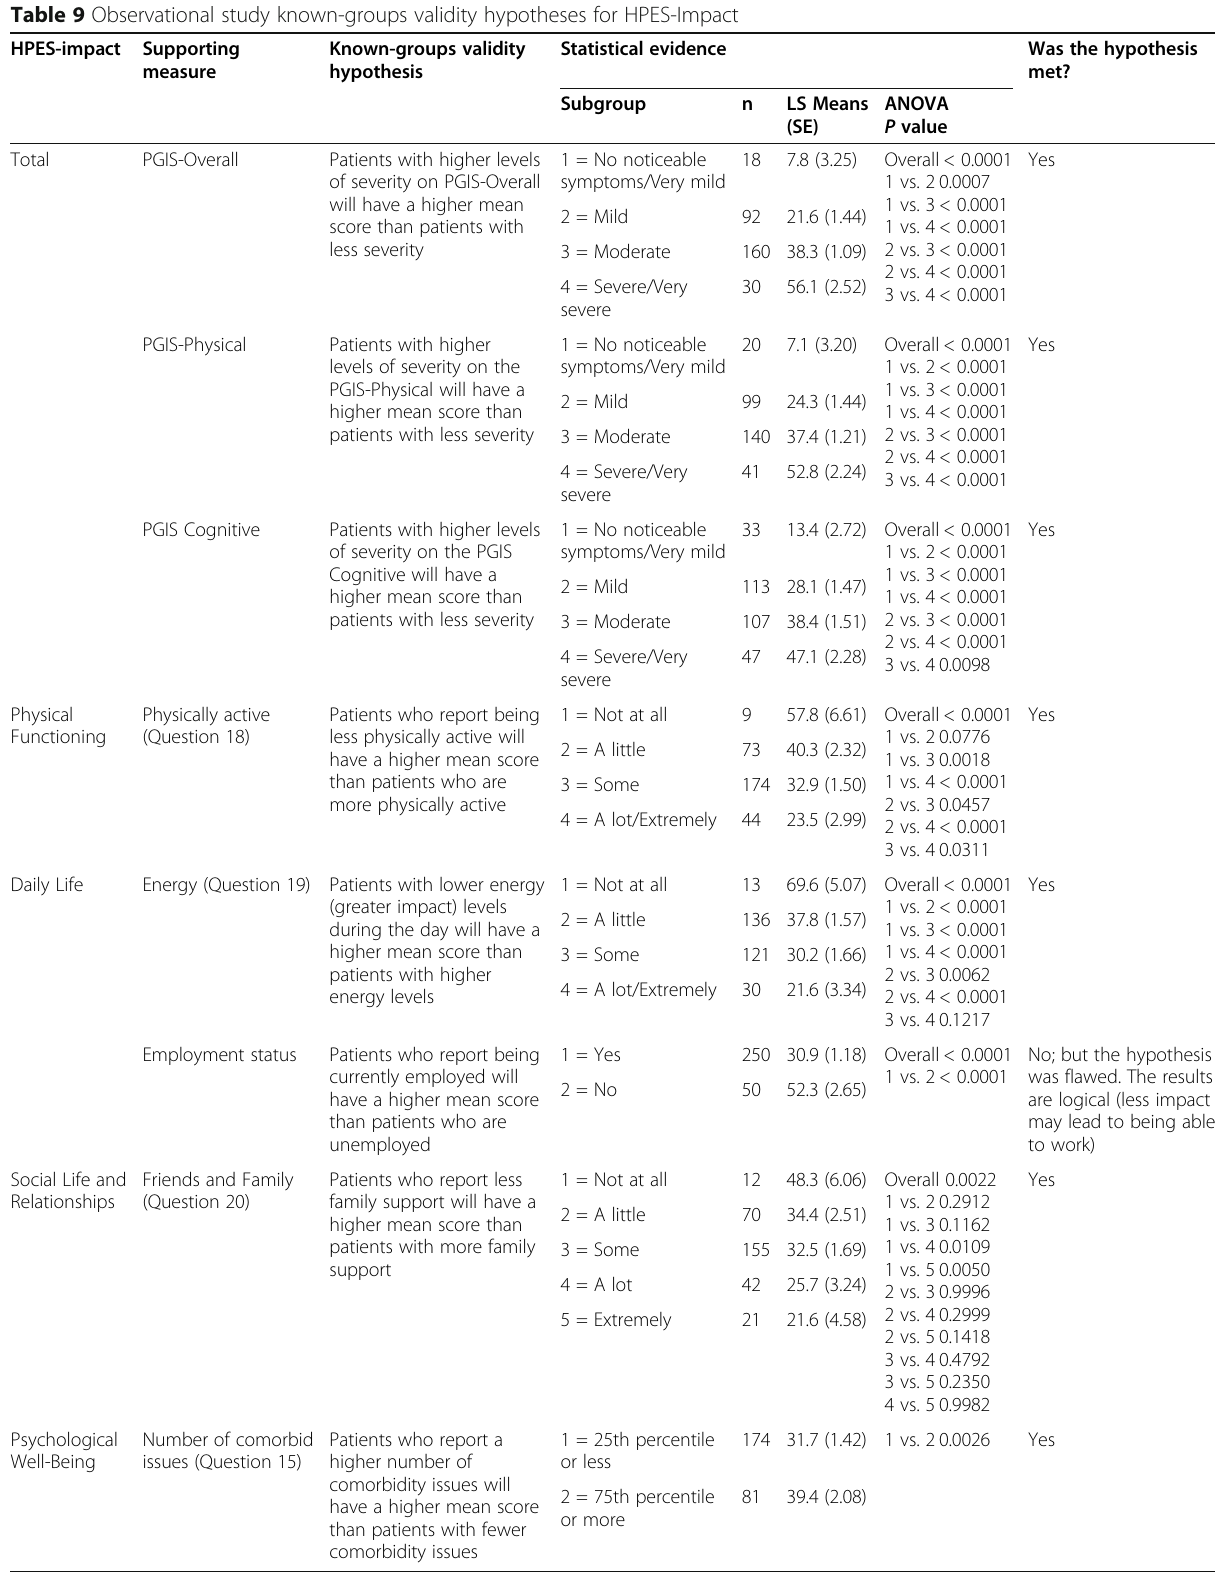
Table 9 Observational study known-groups validity hypotheses for